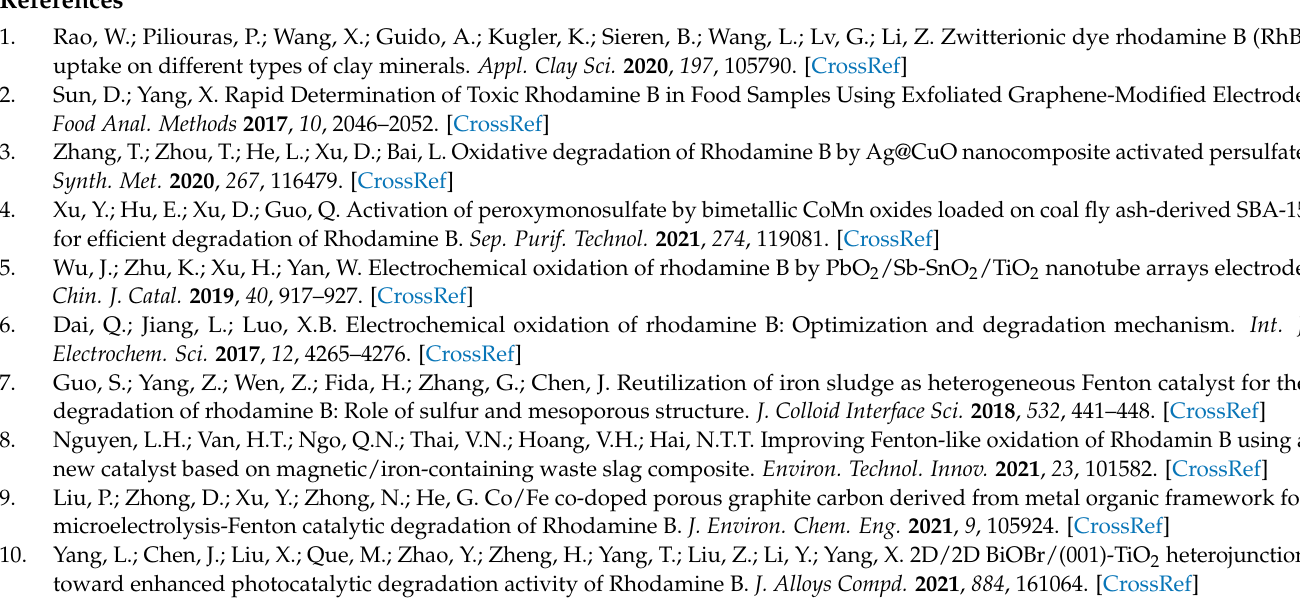
desorption isotherms; Figure S2: High-resolution XPS spectrum of carbon dots; Figure S3: High- resolution XPS spectrum of ZnCdS; Figure S4: Instantaneous photocurrent diagram; Figure S5: Absorbance curve of rhodamine